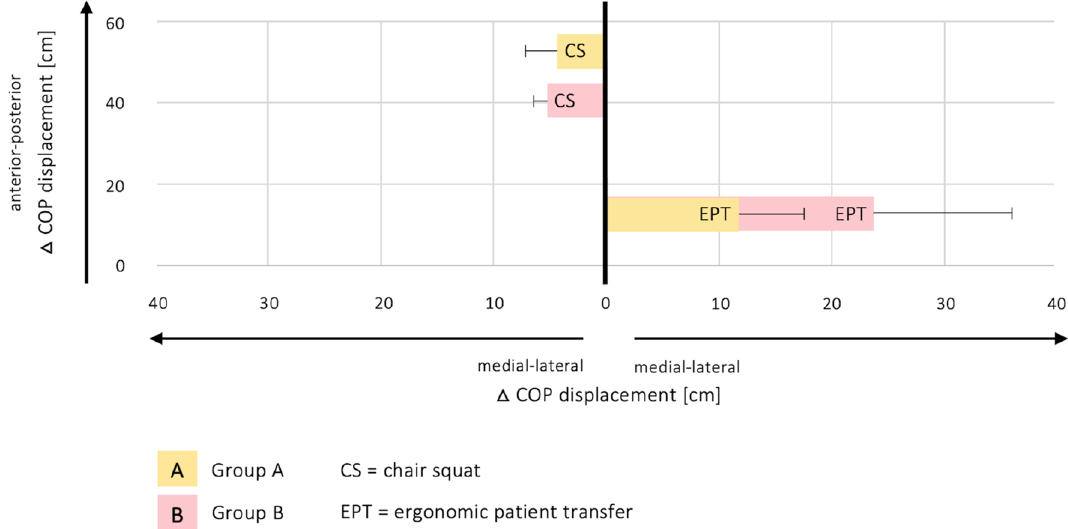
Figure 4. Representation of the medial–lateral COP displacements for both groups and tasks as a function of anterior–posterior COP displacement. The results are presented as means ± standard deviations. Comparisons of each group’s two-sided Wilcoxon signed-rank test reach statistical significance in the anterior–posterior direction of the CS and EPT (Supplementary Material, Table 4). The inter-group comparison showed no statistical significance (Supplementary Material, Table